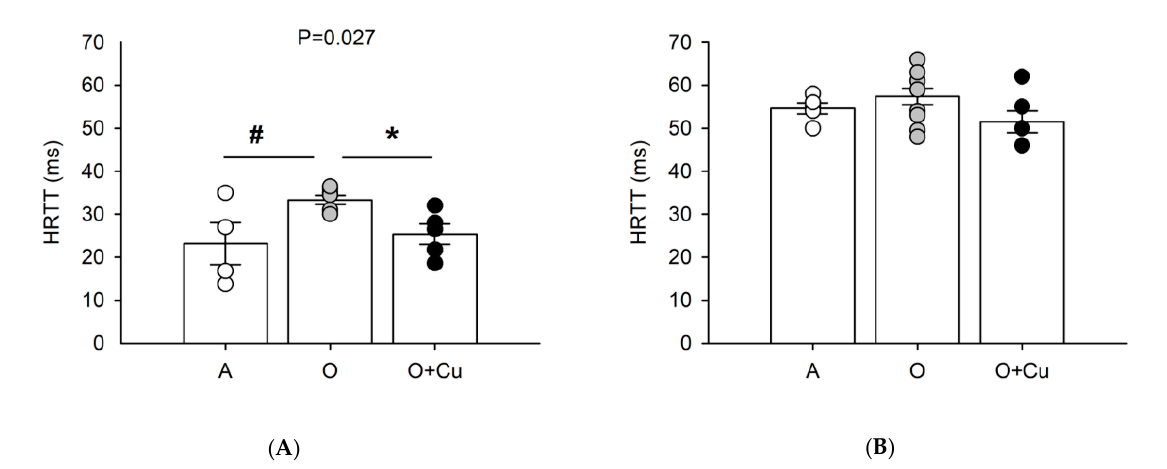
Figure 3. ( A ) Force-frequency curves on Adult (A, open circle), vehicle-treated Old (O, gray circle) and Curcumin-treated Old (O + Cu, closed circle) EDL (left) and soleus (right) muscles of 10ScSn mice. Muscles were stimulated at various frequencies under isometric conditions. Force is expressed as relative to the maximum tetanic force (top charts), as isometric absolute force (middle charts) and as specific tension (isometric absolute tension normalized to muscle wet weight) (bottom charts). Values are mean ± SEM. Significant difference (ANOVA p < 0.05) is indicated by * between O and O + Cu, by # between A and O and by ˆ between A and O + Cu. ( B ) Histograms of half relaxation time of the tetanus (HRTT) of EDL and soleus muscles of 10ScSn mice. Values are mean ± SEM. Significant difference (ANOVA p < 0.03) is indicated by # between A and O p < 0.002) and by * between O and O + Cu ( p < 0.007). EDL data were obtained from n = 4 adult mice; n = 7 old mice and n = 5 curcumin-treated old ones; soleus data were obtained from n = 5 adult mice; n = 10 old mice, and n = 6 curcumin-treated old ones. Table 2. Percentage, size and total number of soleus and EDL myofibers of adult and old mice of two C57BL strains. C57BL Strain (n Animal)